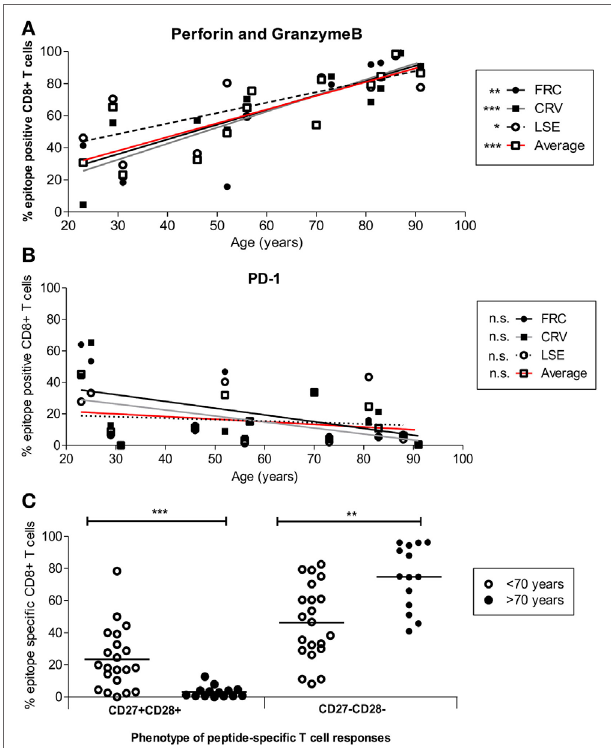
FigUre 5 | Cytotoxic and differentiation phenotype of HLA-Cw*0702- restricted cytomegalovirus (CMV)-specific CD8 + T-cells in relation to age. (a) HLA-Cw*0702-restricted CMV-specific CD8 + T-cells were identified after peptide stimulation followed by intracellular cytokine staining for TNF- α . Intracellular dual expression of perforin and granzymeB was then determined by flow cytometry. R values: FRC = 0.79, CRV = 0.90, LSE = 0.72, and Average = 0.87. (b) CMV-specific cells were identified as in panel (a) and examined for surface expression of PD-1. R values: FRC = -0.47, CRV = − 0.43, LSE = − 0.2, and Average = − 0.25. Values are shown for each individual peptide response (FRC—black circle and black line; CRV—black squares and gray line; LSE—white circles and broken line) and also for the aggregate values of all HLA-Cw*0702-restricted cells (solid red line). Lines represent linear regression, and statistical significance was obtained by Spearman’s rank correlation in GraphPad Prism 6 (* p < 0.05, ** p < 0.01, and *** p < 0.001). (c) HLA-Cw*0702-restricted CD8 + T-cells were identified as in panel (a) . The differentiation status of the epitope-specific CD8 + T-cell responses was then analyzed using CD27 vs CD28 expression. Statistical significance was determined by Mann–Whitney test in GraphPad Prism 6 (** p < 0.01 and *** p <